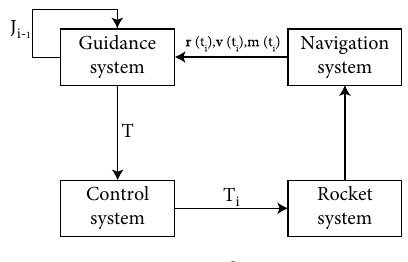
Figure 3: Integrated GNC system. Table 1: Parameter